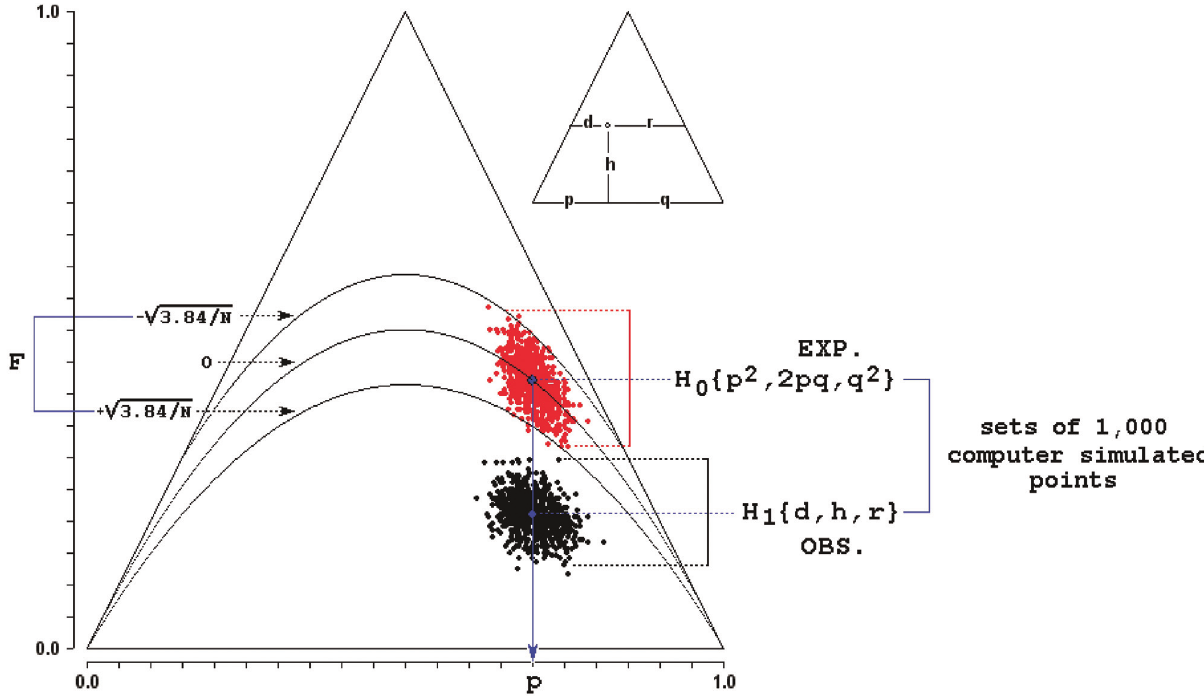
Figure1 -TrilineardiagramshowingtheresultsobtainedwiththeobservedsampleN(AA)=119,N(Aa)=42,andN(aa)=39.Pleaseconsultthearticle’s text (or the user’s manual) for